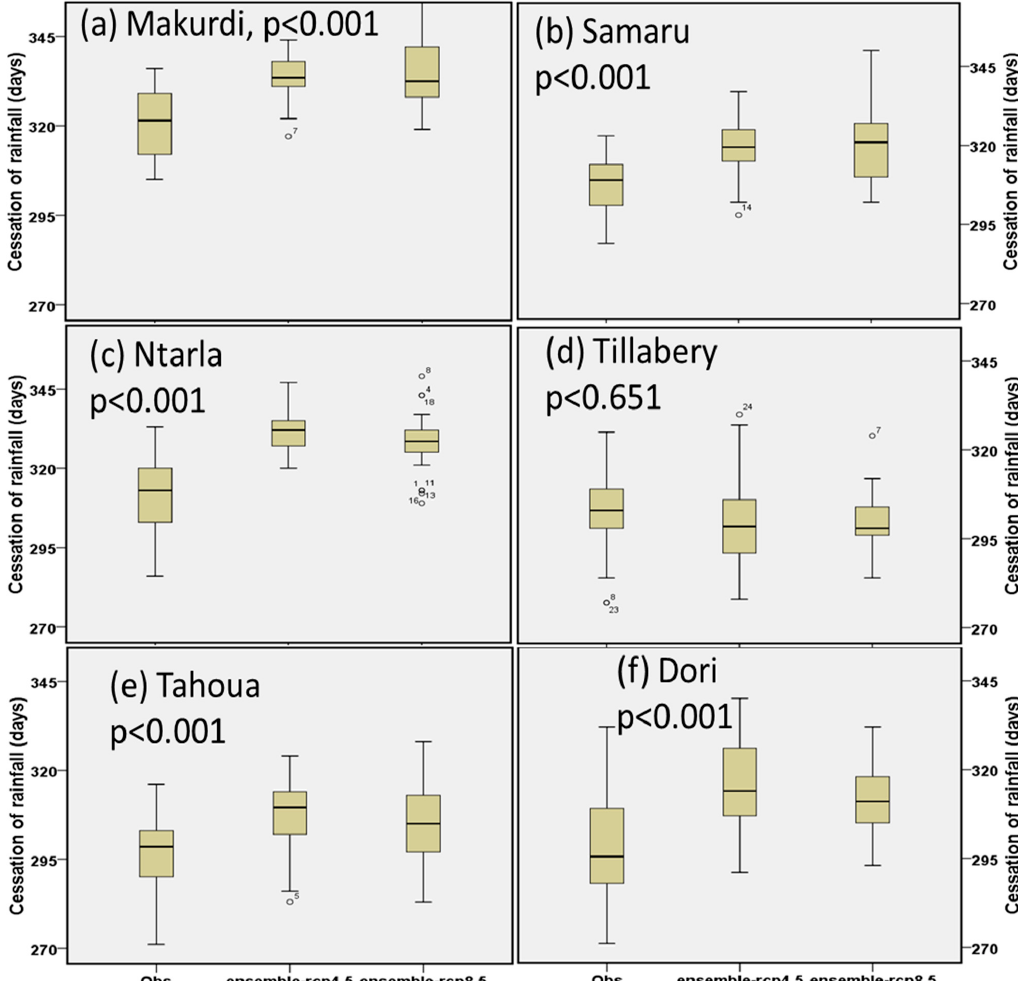
Figure 9. ( a ) Southern (Makurdi) and ( b , c ) Northern (Samaru and NTarla) Guinea and ( d – f ) Sahelian (Tahoua, Tillabery and Dori) average ensemble change in rainfall cessation for the future period (2021/2025–2050) relative to the baseline (1976/1980–2005). All in Julian days.